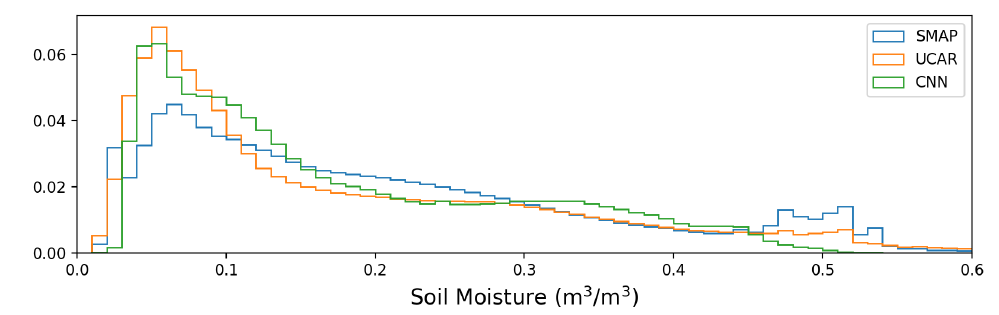
Figure 15. Comparison of the SMAP, UCAR, and CNN-based soil moisture distribution from the validation window. The features near 0.5 m 3 /m 3 in the SMAP/UCAR distributions are related to low-quality flags in regions such as the Amazon.